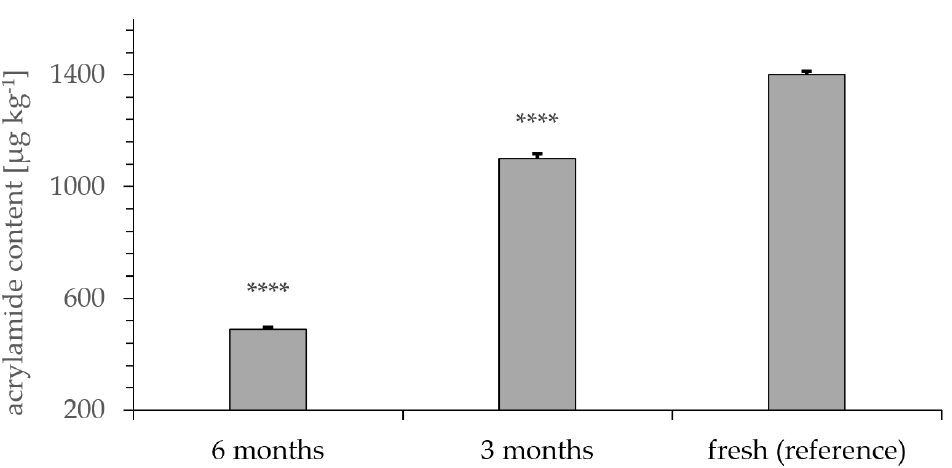
Figure 6. Acrylamide content of roasted and milled rye analyzed by GC-MS after xanthydrol derivatization. Samples were measured fresh and after 3 months and 6 months of controlled storage. Samples ( n = 5) were roasted at 140 °C for 30 min and stored in closed plastic containers at 25 °C. **** p < 0.0001 indicates significant differences from the reference.